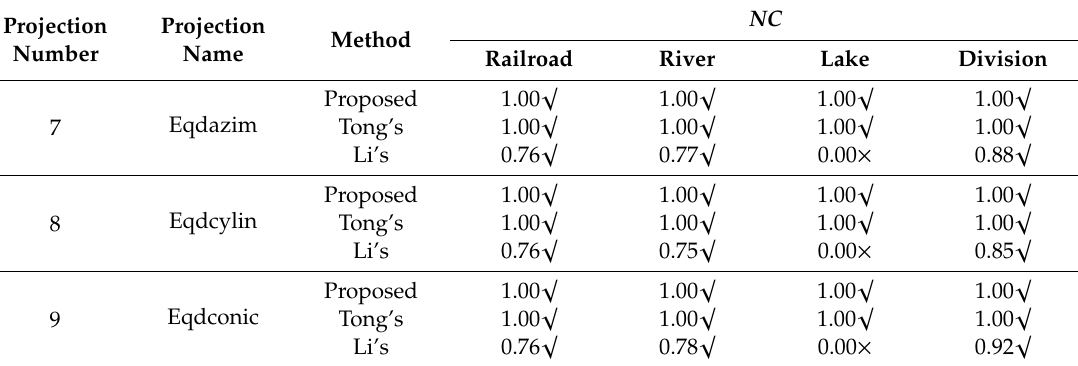
Table 7. The results after equidistant projection transformation.